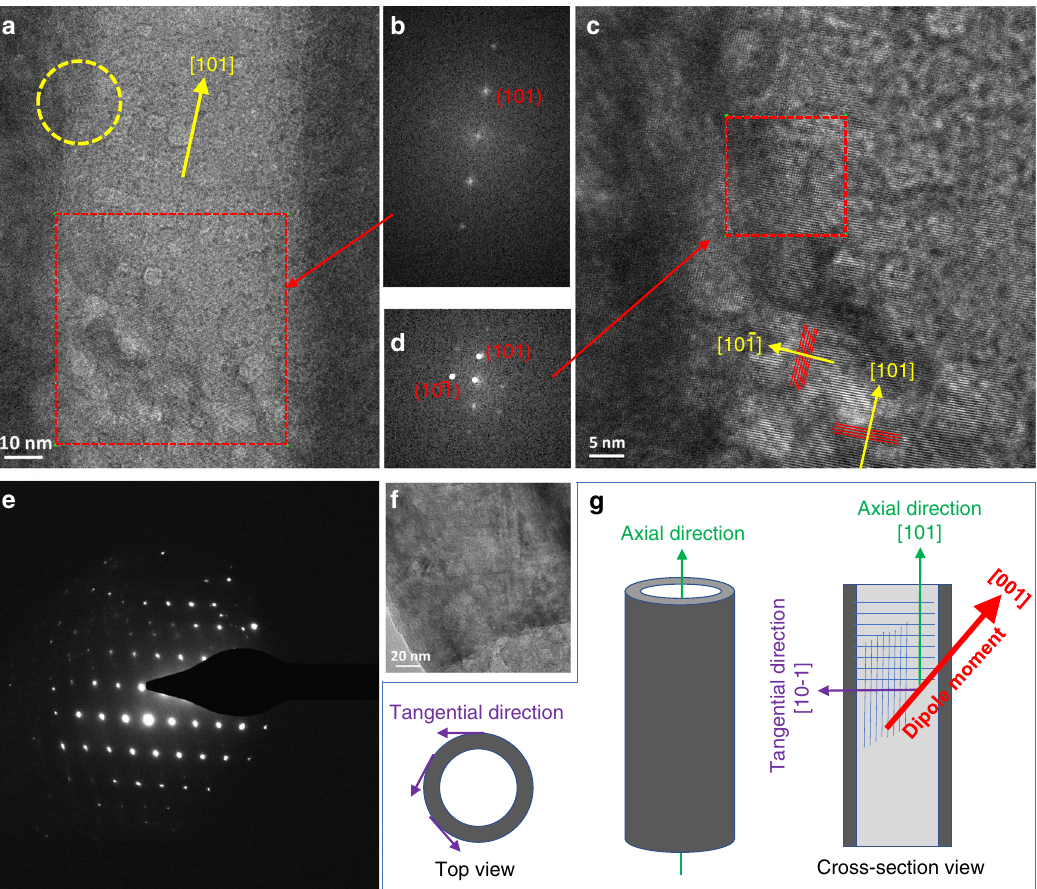
Fig. 4 Crystallographic orientation and atomic structure of the TiO2 tube. a A typical TEM image of a single tube in the Li-TiO 2 sample, prepared by cutting the tube fi lm along the axial direction by focused ion beam (FIB, see Supplementary Fig. 9) and ( b ) FFT images of the a indicated with red dash square. c An enlarged image of the zone in a marked with a yellow dash circle. d The FFT images of the c indicated with red dash square. They assisted to index the lattice fringes and crystallographic orientation of the tube. e Selected area electron diffraction patterns recorded from a single TiO 2 tube and ( f ) showing the corresponding part of the tube for recording the patterns. g Schematic of the axial and tangential directions of the tubes. The direction of dipole moment, axial crystallographic orientation, and tangential direction are illustrated in the cross-section view.